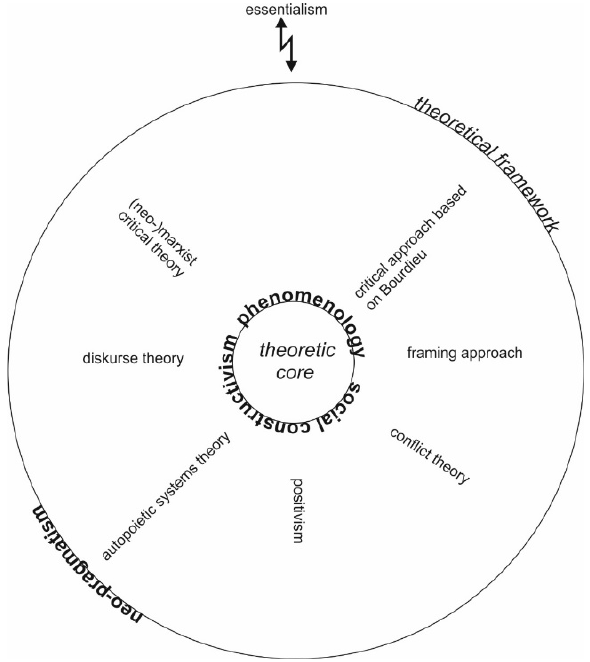
Figure 6. The different landscape-theoretical approaches between theoretical framework and theo- retical core. The inner ring symbolizes the theoretical core formed by Phenomenology and social constructivism, which ultimately represent two sides of the same coin, one side defining the rela- tionship of the individual to the non-social environment (Phenomenology), the other side (social constructivism) defining the relationship of the individual to the social environment. The other theories complement this core. The outer circle defines the neo-pragmatic framework, which includes the theories that can be meaningfully integrated. Essentialism stands outside the circle, rejecting VR as accidental (own representation).